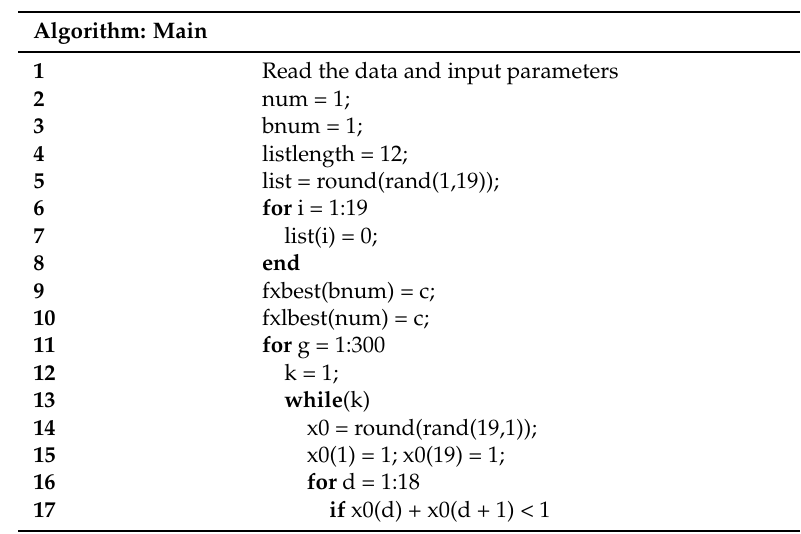
Table A1. Main process of tabu